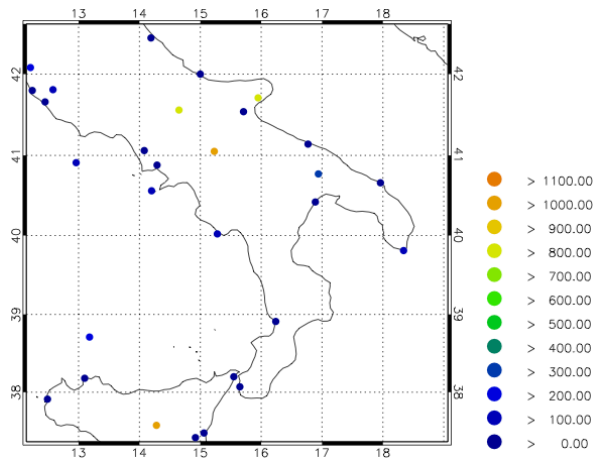
Figure 2. The SYNOP stations distributed through the GTS over southern Italy. The colours represent the station elevation.